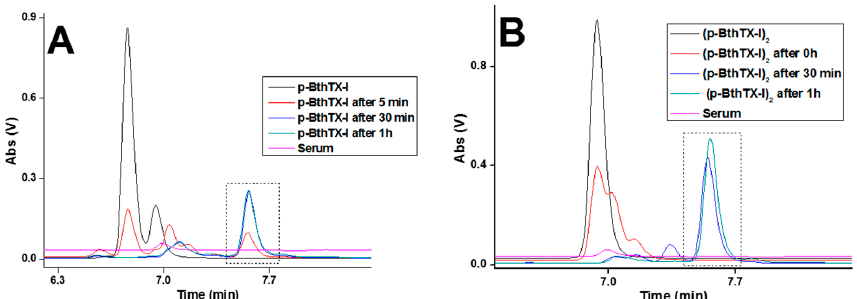
Figure 1. Serum stability assays by analytical high-performance liquid chromatography (HPLC). ( A ) p-BthTX-I and ( B ) (p-BthTX-I) 2 were incubated with human serum for the indicated times. Analytical HPLC was performed on a Shimadzu (Kyoto, Japan) system using a C18 column (4.6 × 150 mm, Phenomenex) with a linear gradient of solvent B (5–95%) at 1 mL/min for 15 min (Solvent A: 0.045% trifluoroacetic acid (TFA) in water. Solvent B: 0.036% TFA in acetonitrile). Marked boxes in the